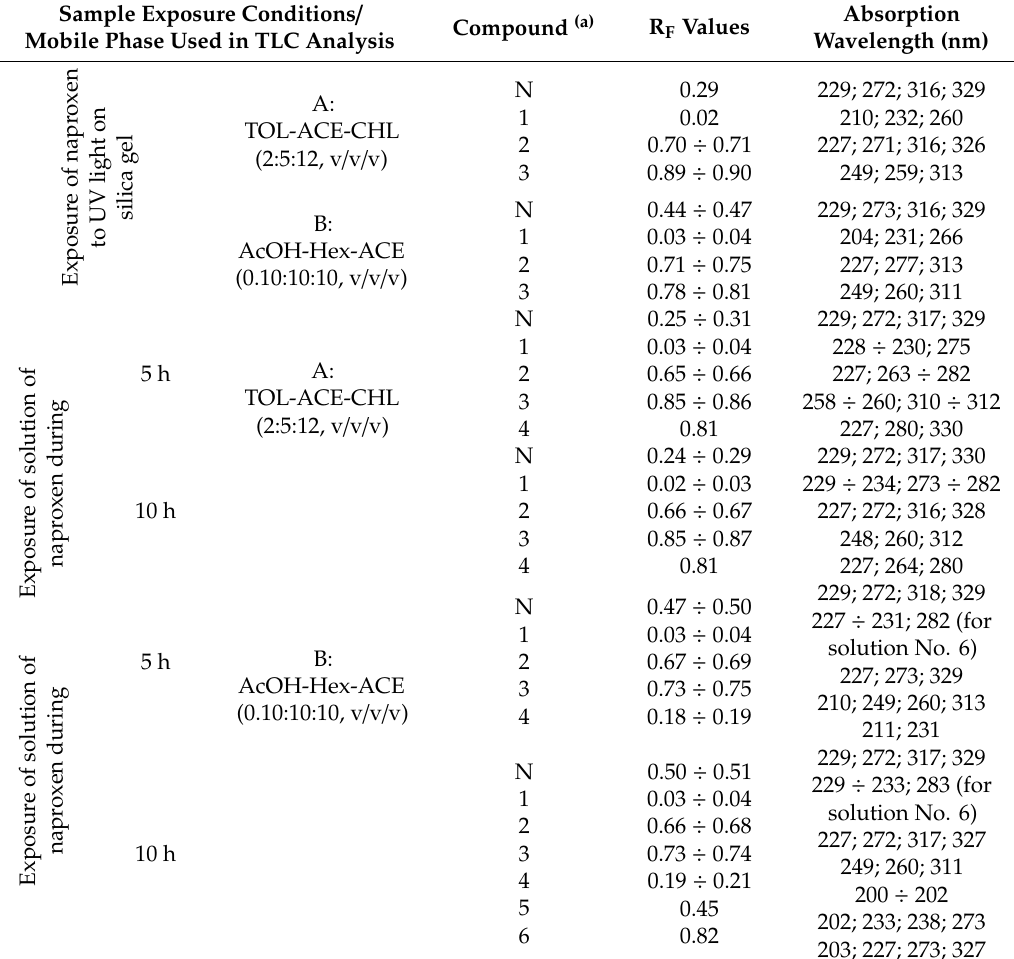
Table 2. Full descriptions the chromatographic peaks of examined naproxen and its degradation products formed during naproxen exposure to UV light obtained using thin-layer chromatography (TLC) /